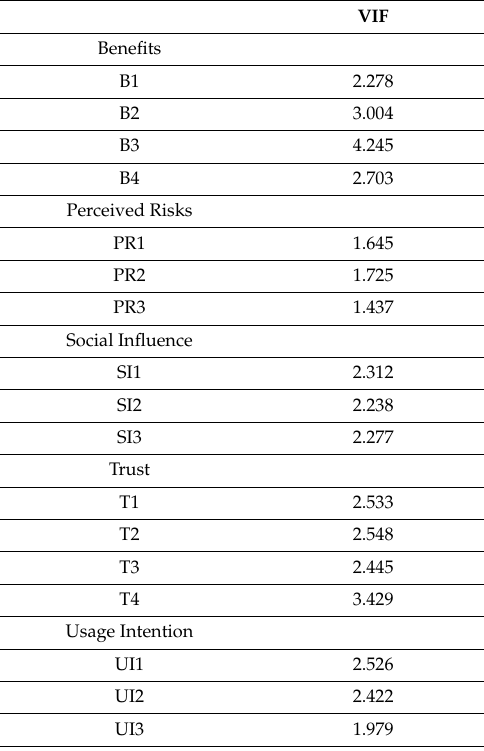
Table 5. Variance inflation (VIF) values.